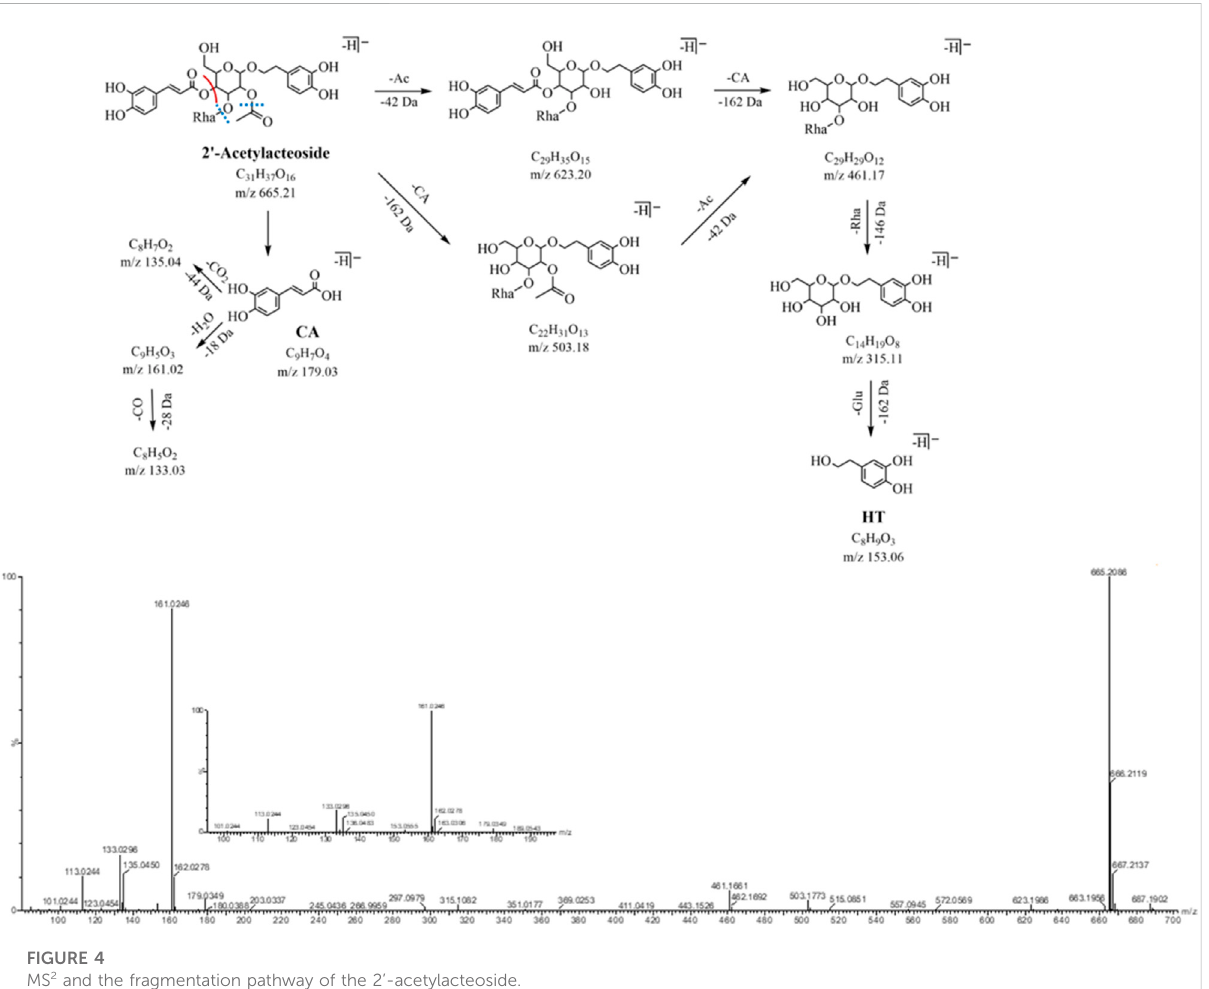
FIGURE 4 MS 2 and the fragmentation pathway of the 2 ’